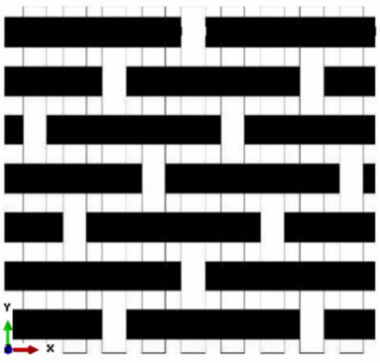
Figure 5. Five-harness satin weave composites